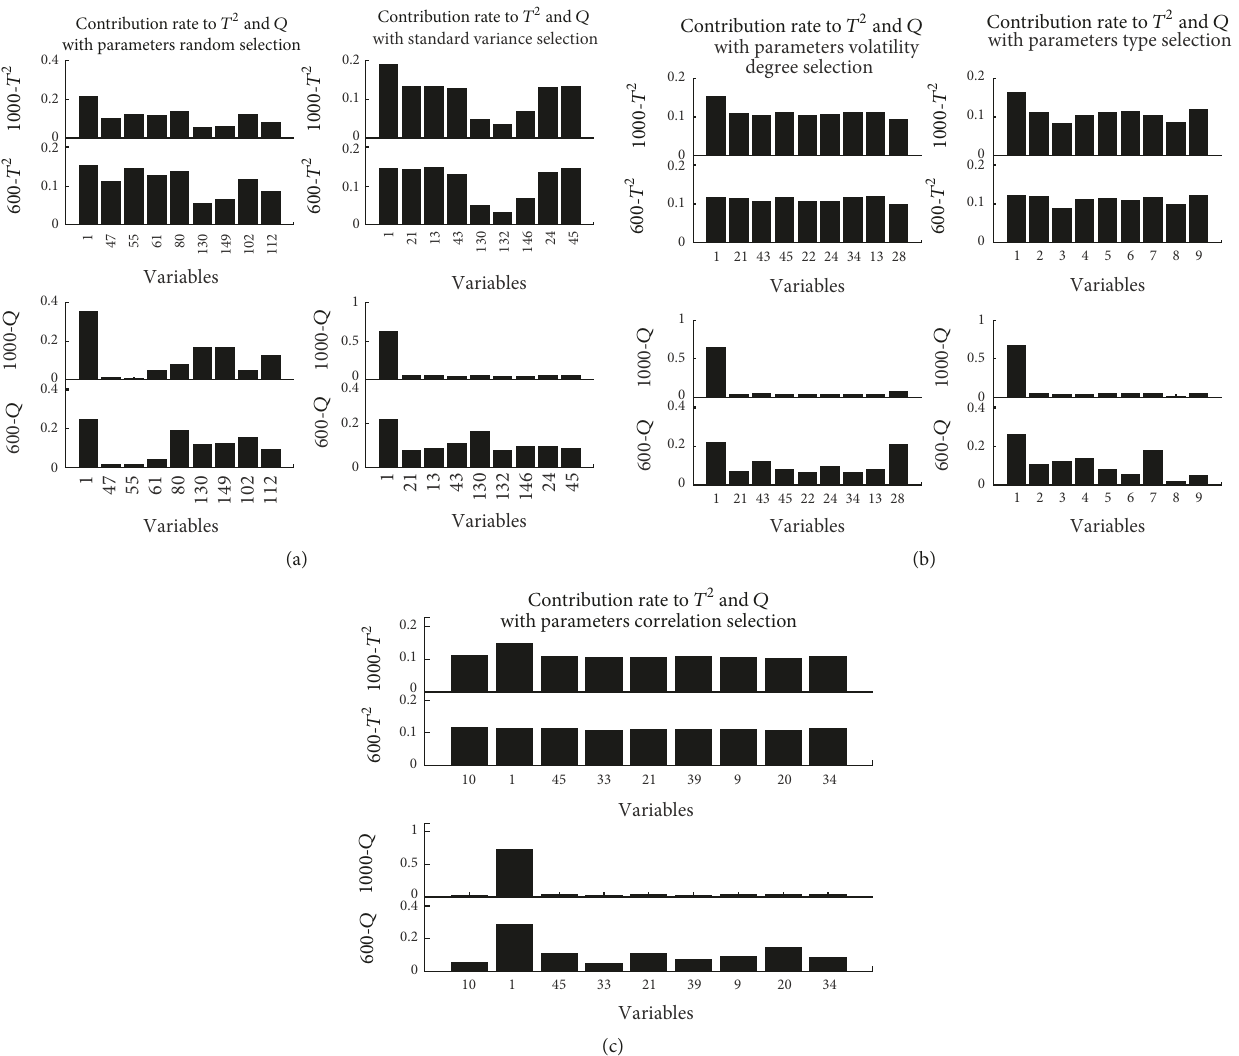
Figure 12: Contributions of variables to 𝑄 and 𝑇 2 statistics in 5 PCA models with a small drift on 1# sensor.